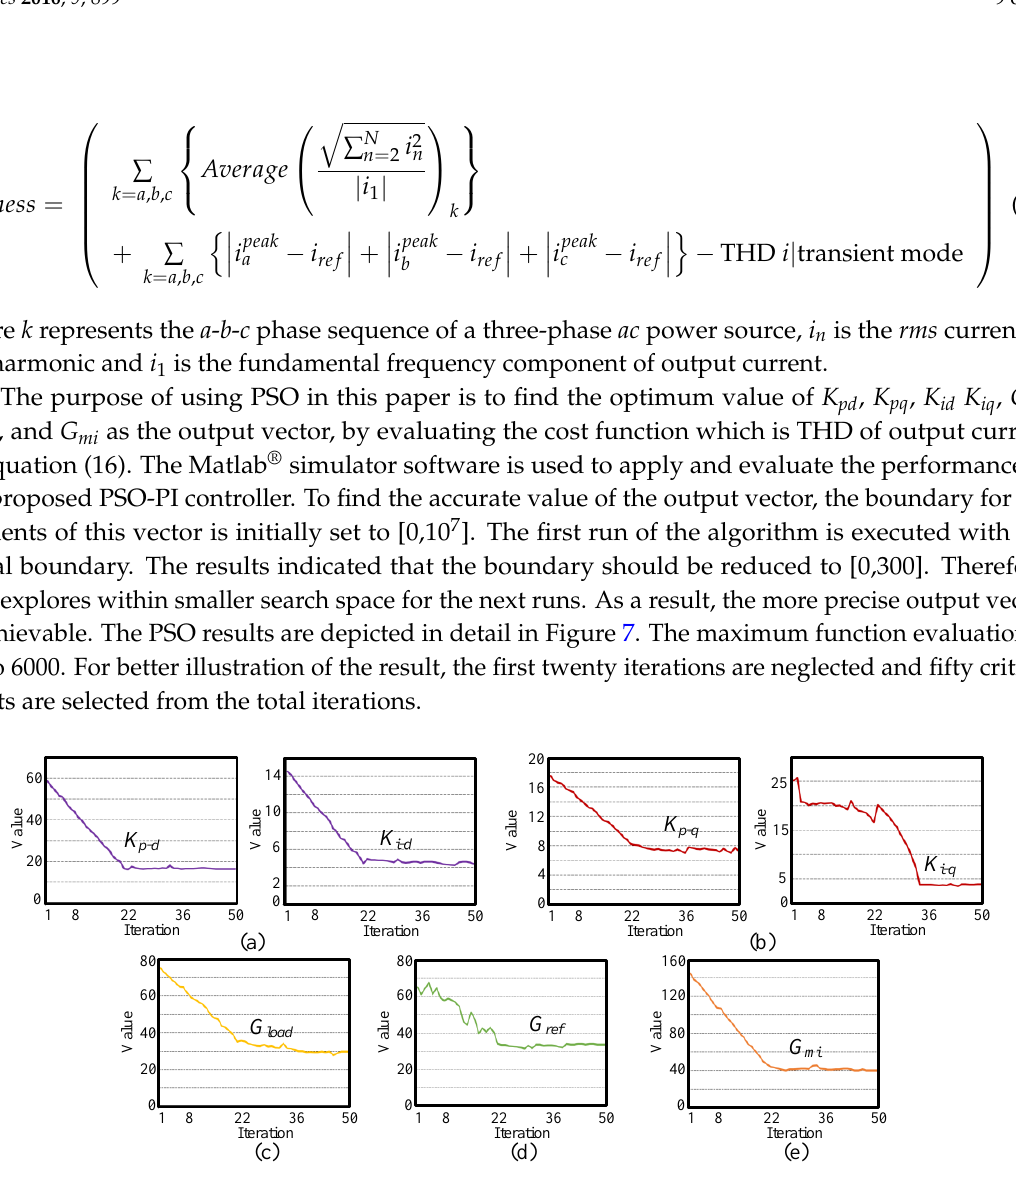
Figure 7. The results of optimizing ( a ) K p – d – K i – d ; ( b ) K p – q – K i – q ; ( c ) 𝐺 𝐼 ( e ) 𝐺 𝑚𝑜𝑑𝑢𝑙𝑎𝑡𝑖𝑜𝑛_𝑖𝑛𝑑𝑒𝑥 .